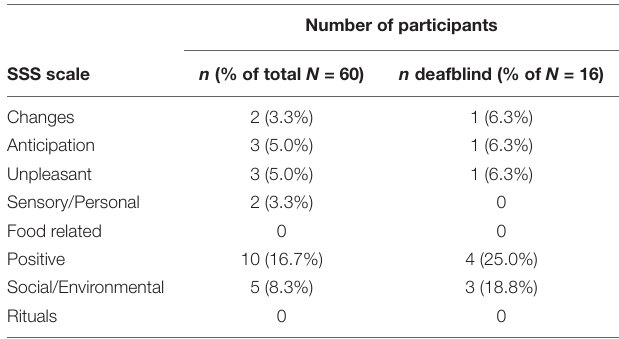
TABLE 3 | Number of participants with two SD’s or more above the mean for the SSS scale compared to non-verbal persons. Number of